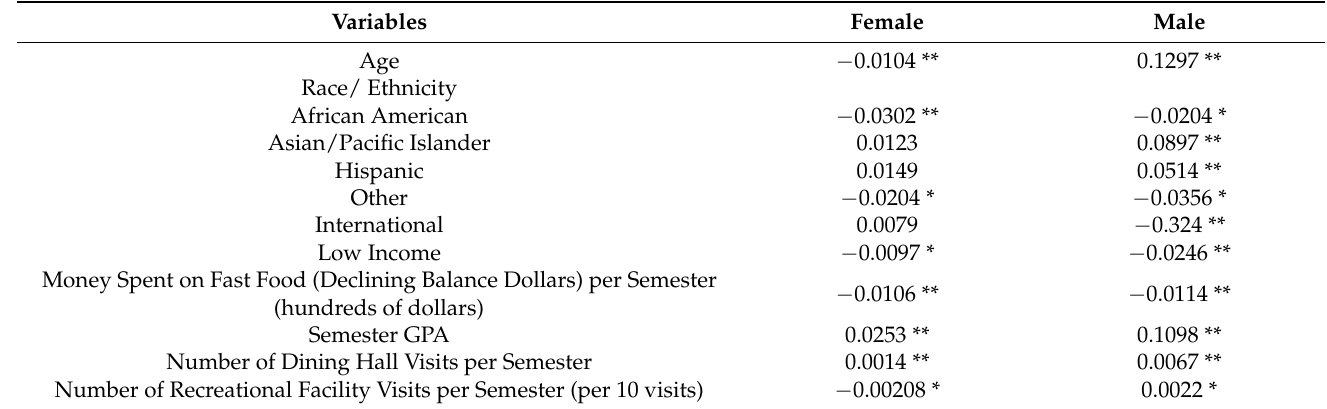
Table 3. The Association between Demographic, Economic, and Behavioral Factors and Students’ Average Fast-Food Health Score (FFHS), N =